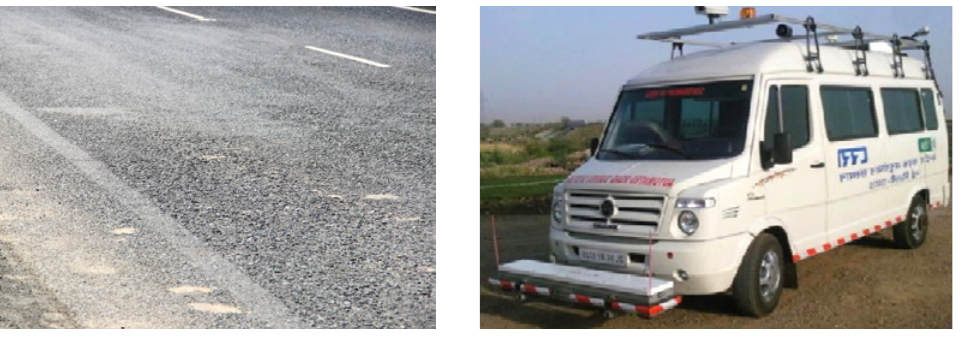
Figure 3. Network survey vehicle with different components